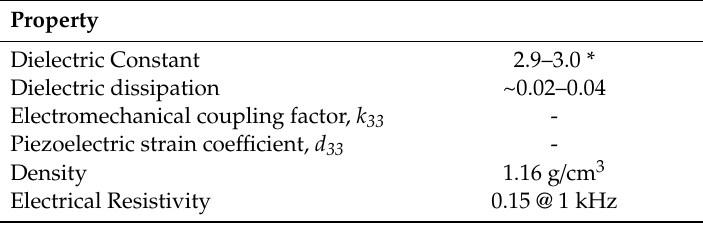
Table 2. Physical, dielectric and piezoelectric properties of DGEBA